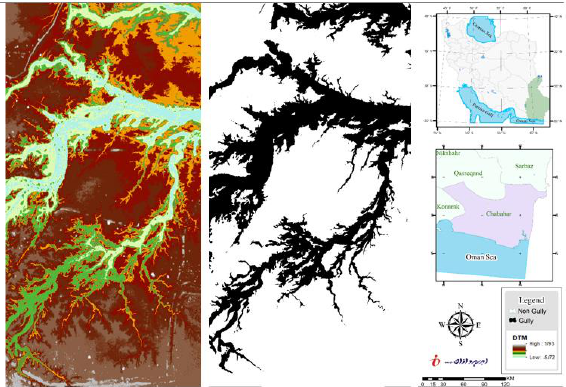
Figure 9. The binary result of extracted gullies with heuristic algorithms